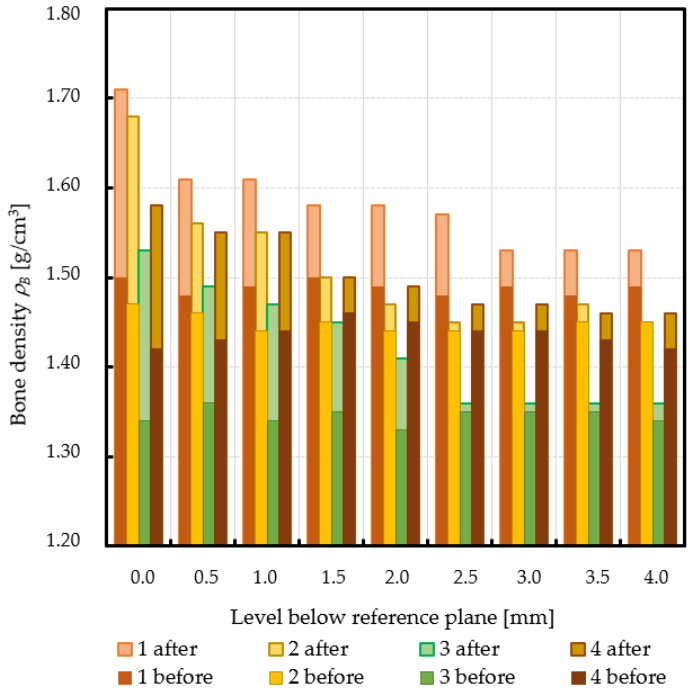
Figure 7. Changes in subchondral trabecular bone volumetric density values in analyzed femoral head samples at different levels below the reference plane.